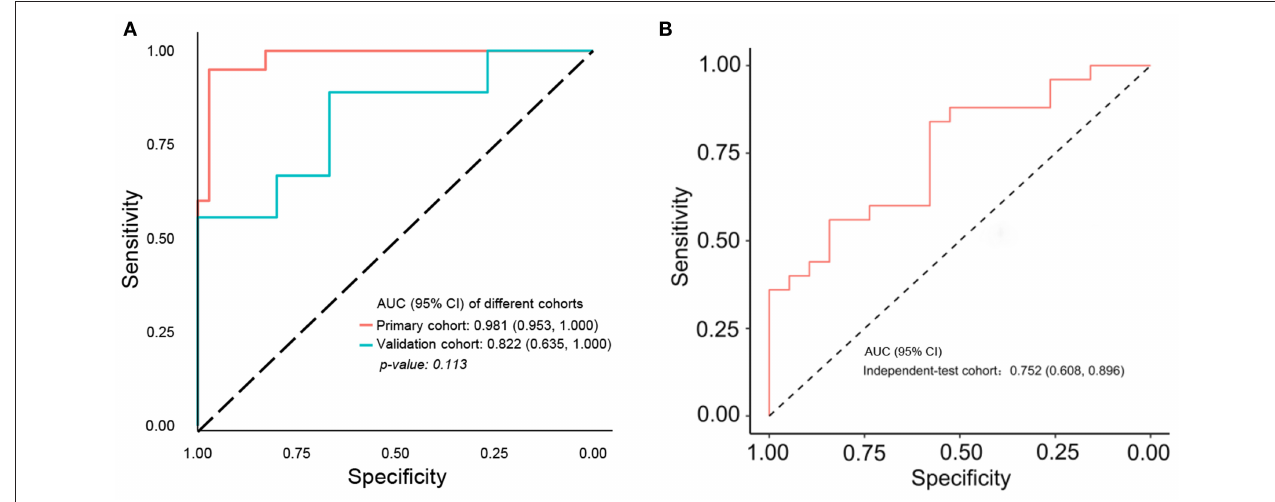
FIGURE 4 | ROC curve of multiscale radiogenomics model. (A) ROC curve of multiscale radiogenomics model in the primary cohort and validation cohorts. (B) ROC curve of multiscale radiogenomics model in the independent-test cohort.